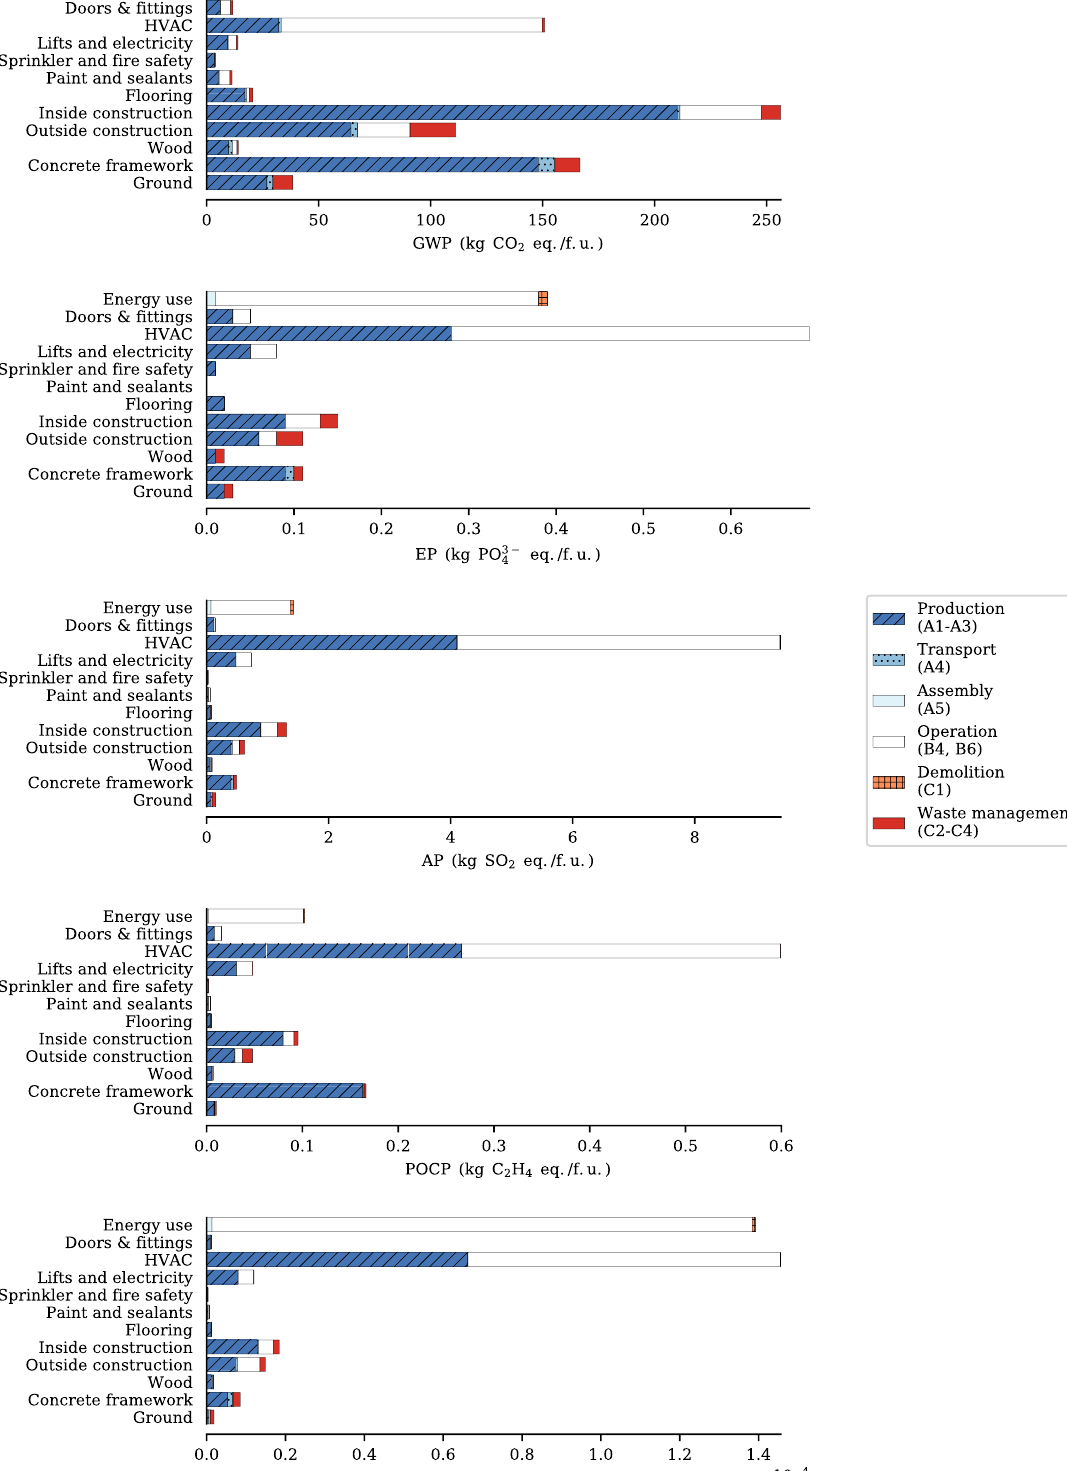
Figure 4. Impact of the different parts in the building for the environmental impact categories investigated, with changed parameters for electricity mix, copper and